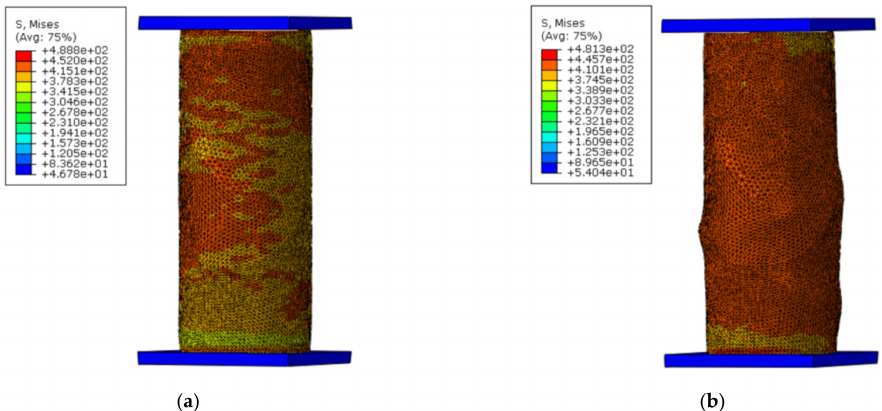
Figure 13. Stress development of specimen AT1100C50A: ( a ) 50% ultimate load; ( b ) 80% ultimate load.